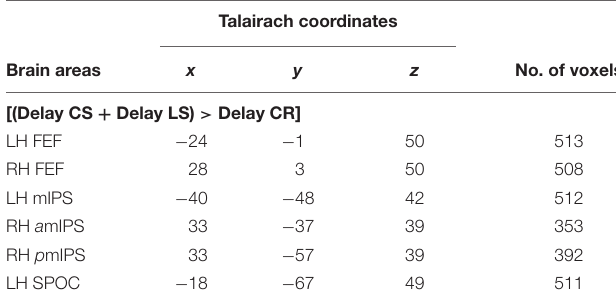
TABLE 2 | Talairach coordinates and number of voxels for contrast no.